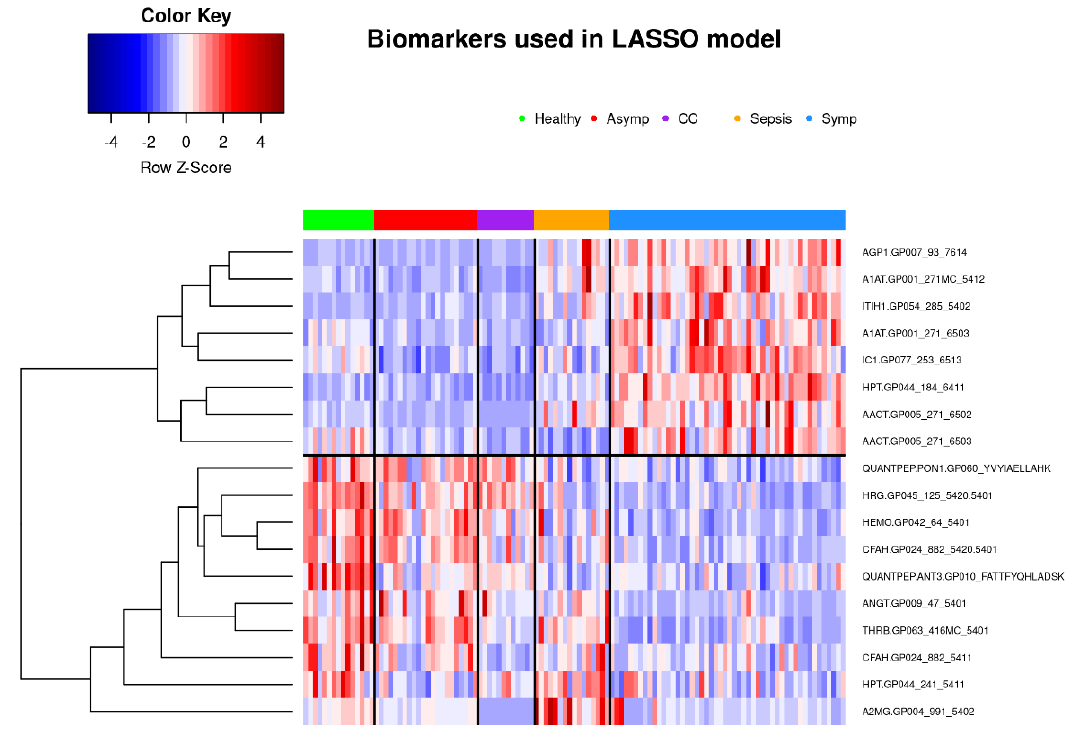
Figure 12. Heatmap showing retained biomarkers in LASSO-regularized classifier for all patients in both training and testing sets. Subjects are clustered into phenotype groups column-wise and hierarchically clustered row-wise. Row-wise Z-scores determine the color of each cell.